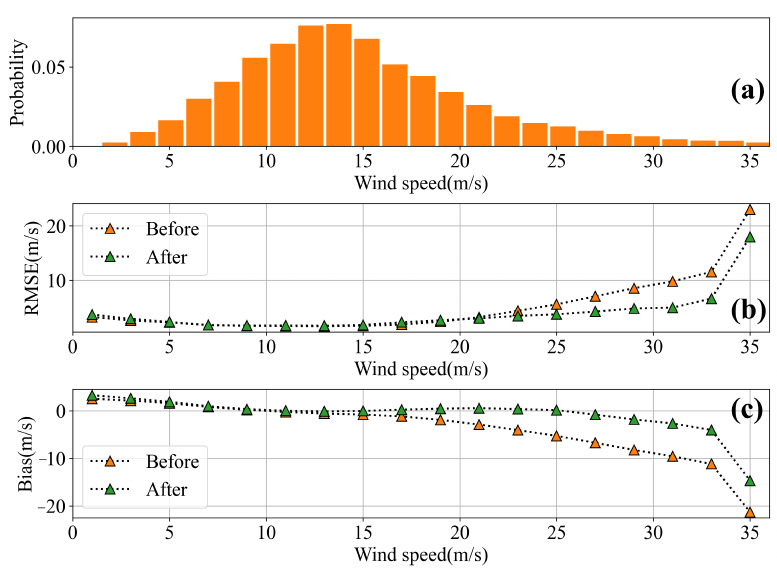
Figure 7. Comparisons before and after revision by the BP-NN algorithm. ( a ) Two-dimensional histogram of 30% test set in the range 0–35 m/s. ( b ) RMSE in wind speed before and after revision by the BP-NN algorithm compared to SMAP. ( c ) Bias in wind speed before and after revision by the BP-NN algorithm compared to